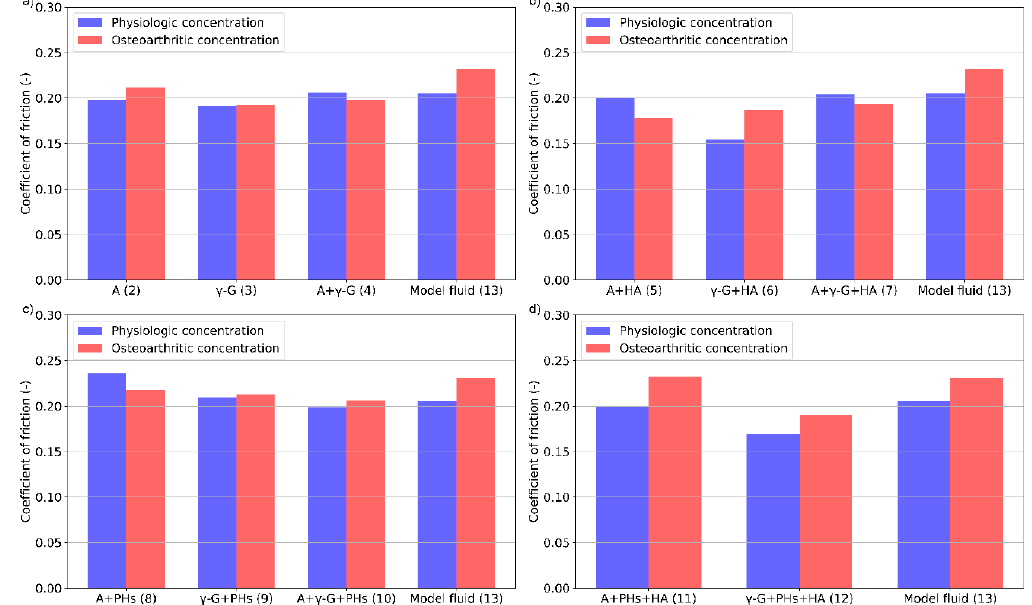
Figure 4. The e ff ect of concentration on the friction coe ffi cient for various protein- ( a ), protein + HA- Figure 4. The effect of concentration on the friction coefficient for various protein- ( a ), protein + HA- ( b ), PHs- ( c ), and HA + PHs- ( d ) based lubricants. (A—Albumin, γ -G— γ ( b ), PHs- ( c ), and HA + PHs- ( d ) based lubricants. (A—Albumin, γ -G— γ -Globulin).